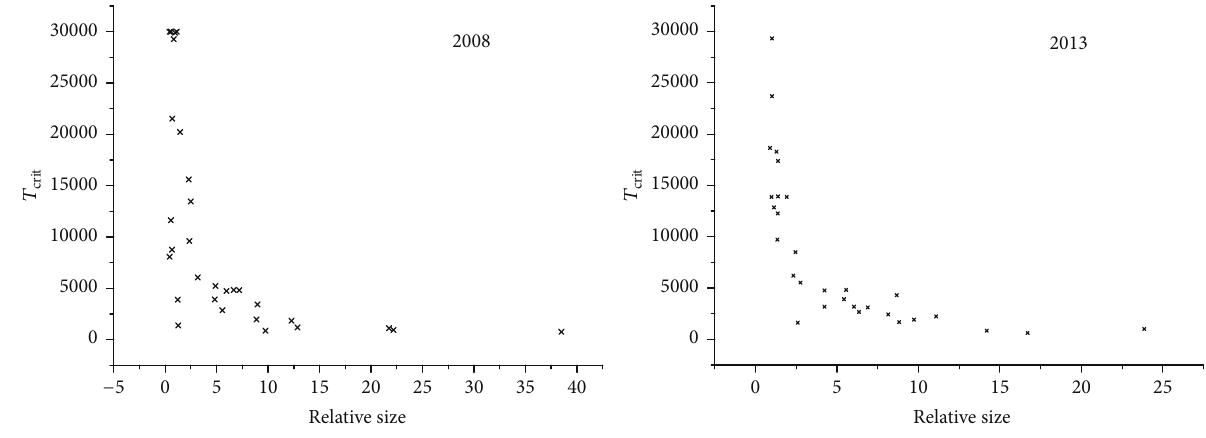
Figure 5: The correlation between RS and 𝑇 crit in different